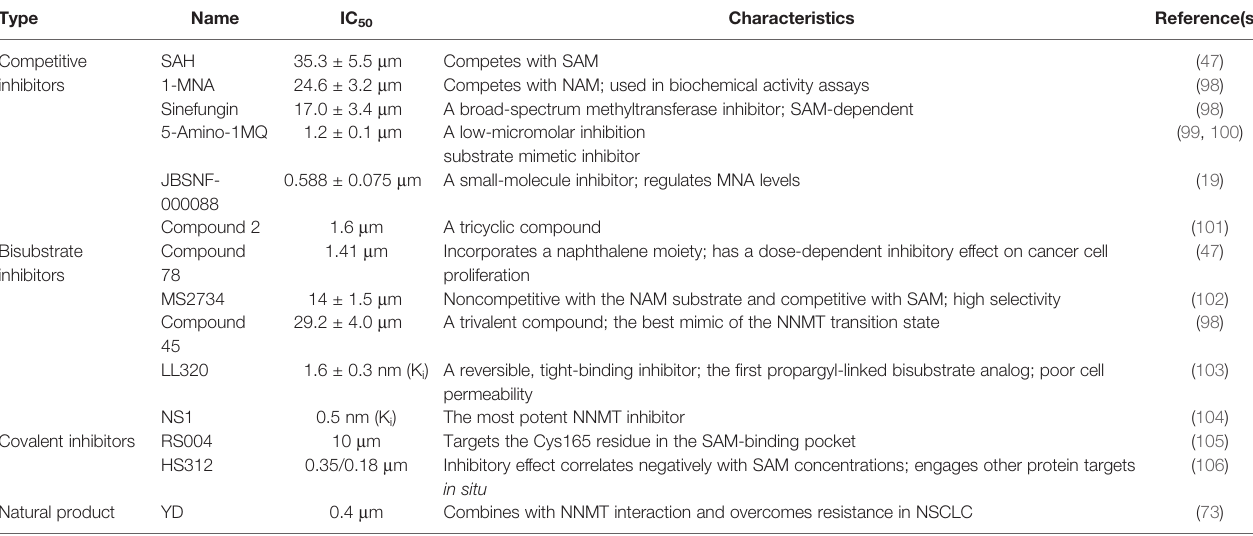
TABLE 2 | The present NNMT